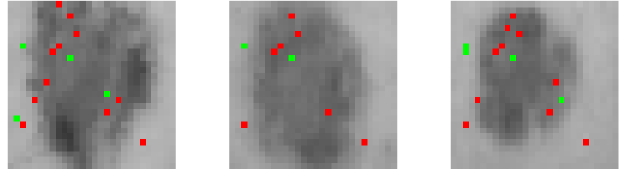
Figure 10. Three training samples belonging to the “malignant” class. The example in the middle activates a single rule, while the examples on the left and right each activate an additional rule.